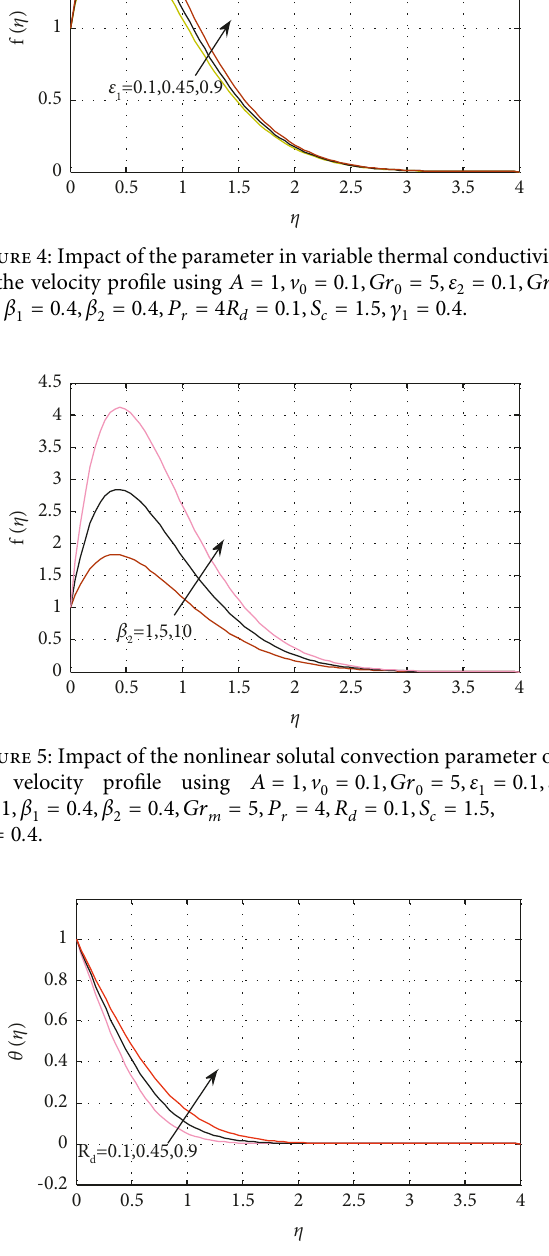
� 0 . 1 , Gr � 5 , ε � 0 . 1 , ε � 0 . 1 , β 0 0 1 2 � 5 , P � 4 , R � 0 . 1 , S � 1 . 5 , c � 0 . m r d c 1